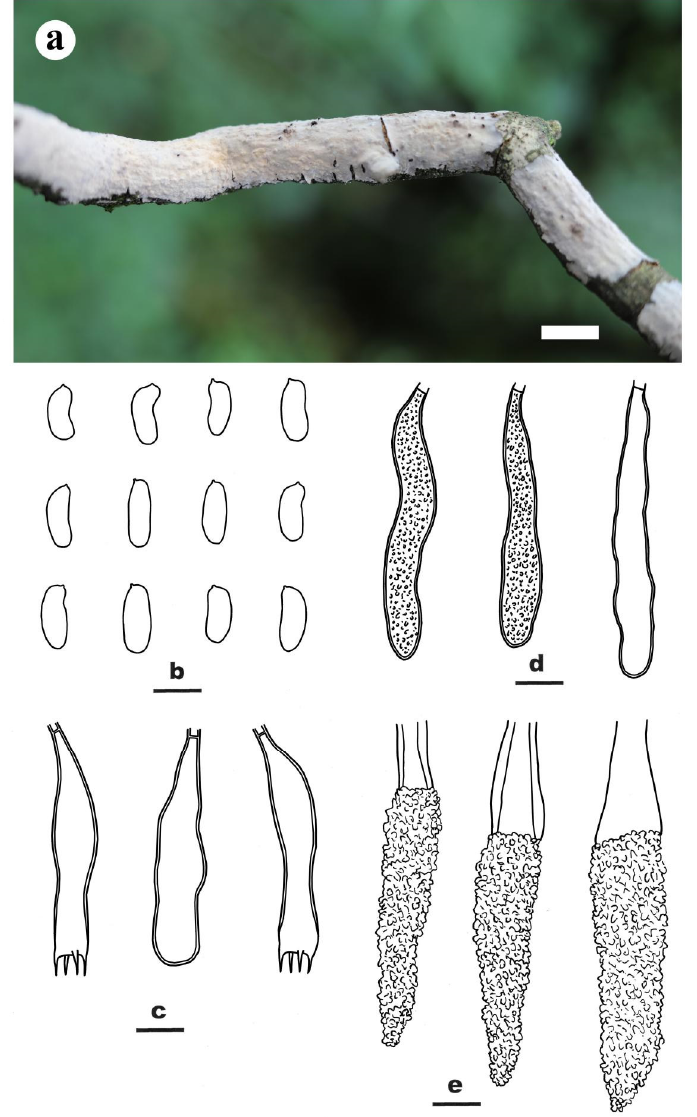
Figure 4. Peniophora major (from the holotype BJFC 026589). Scale bars: ( a ) = 1 cm; ( b – e ) = 10 µm. ( a ). Basidiomes; ( b ). Basidiospores; ( c ). Basidia and a basidiole; ( d ). Gloeocystidia; ( e ).